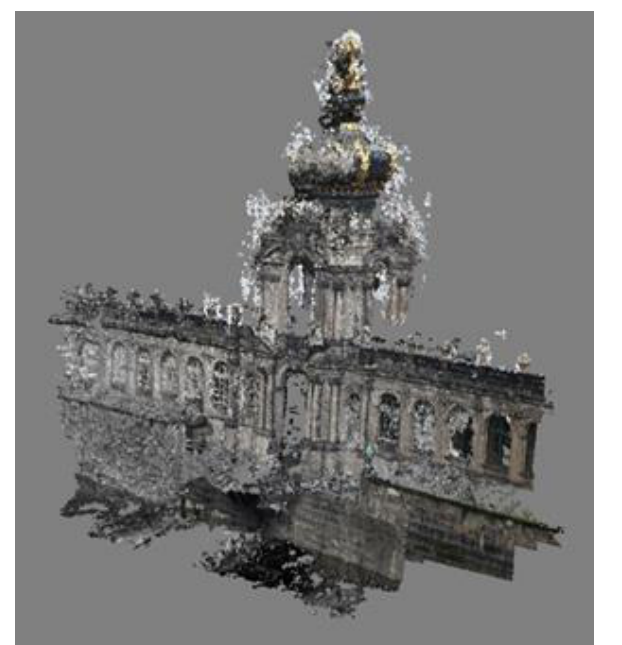
Figure 10. Point cloud based on 13 historical